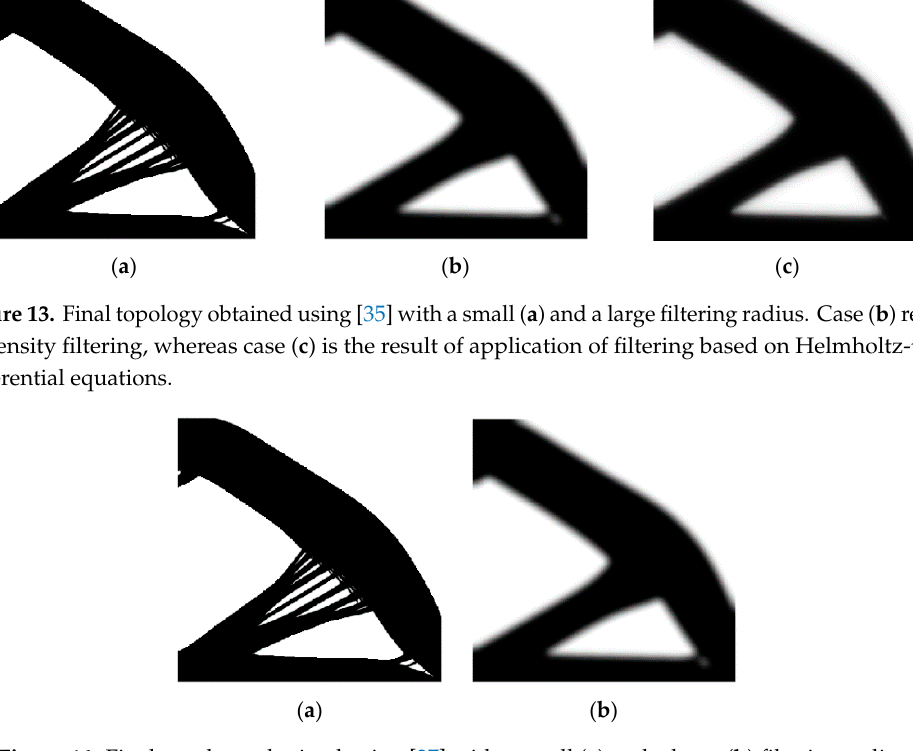
Figure 15. Initial irregularity of the mesh density ( a ) and the final topology ( b ).